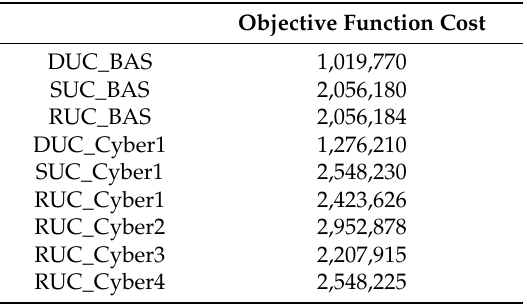
Table 1. Objective function cost (in USD) for different